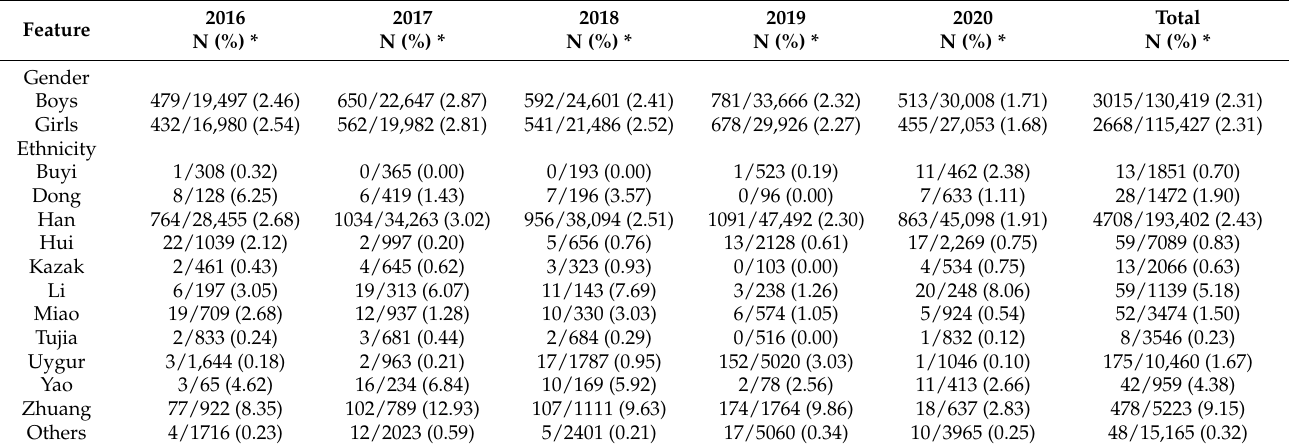
Table 2. Enterobius vermicularis infection among children by gender and ethnicity in China from